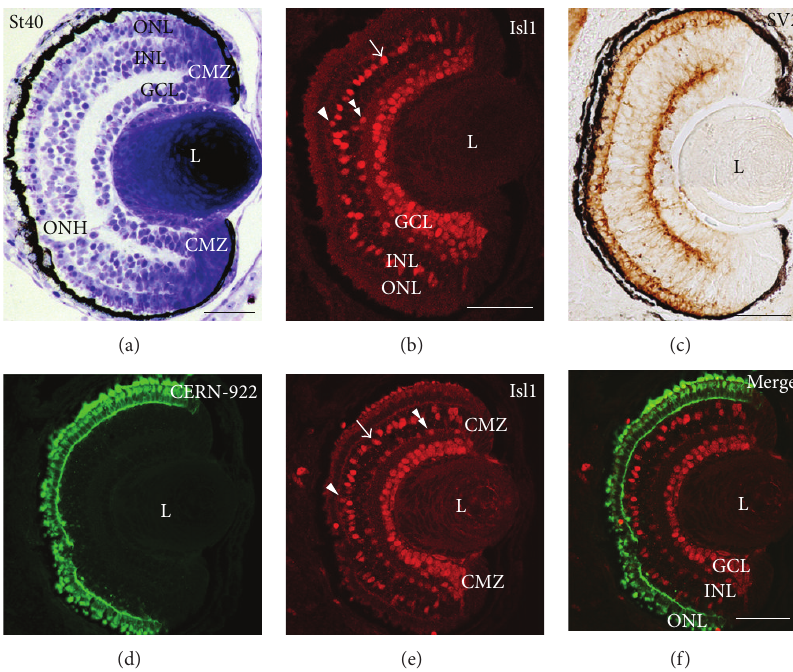
Figure 6: Morphological features and expression patterns of Isl1 and other cell differentiation markers in the St40 Xenopus laevis retina. (a) Toluidine blue-stained transverse retinal resin sections revealed that the typical multilayered structure was clearly distinguishable, showing morphological features of maturation. The CMZ was visible in the peripheralmost region. (b) Isl1 immunoreactivity was clearly established in abundant nuclei located in the GCL, whereas the INL contained Isl1 labeling that corresponded to horizontal (arrowhead), bipolar (arrow), and amacrine cells (double arrowhead). (c) SV2 expression in the plexiform layers extended to more peripheral regions. (d)–(f) The CERN- 922 labeling in the ONL coursed in parallel with Isl1 immunoreactivity and reached the periphery by this stage. CMZ: ciliary marginal zone; GCL: ganglion cell layer; INL: inner nuclear layer; L: lens; ONH: optic nerve head; ONL: outer nuclear layer. Scale bars: 100 𝜇